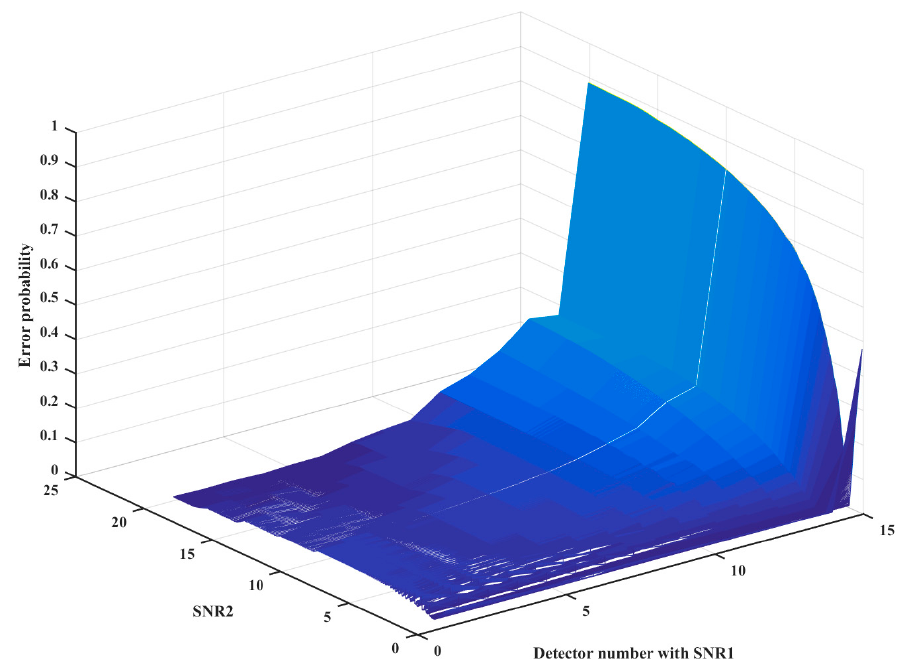
Figure 5. The error with the variation of 1 N and 2 SNR .